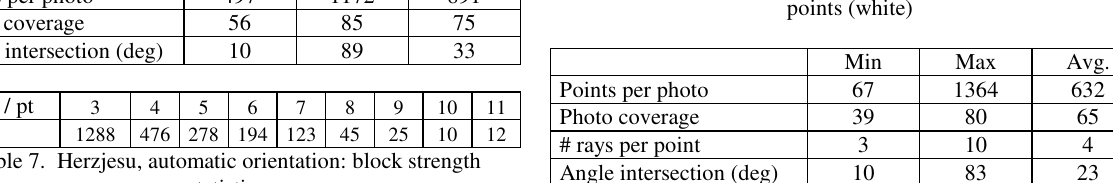
Figure 6. Orientation of castle sequence: camera stations; tie